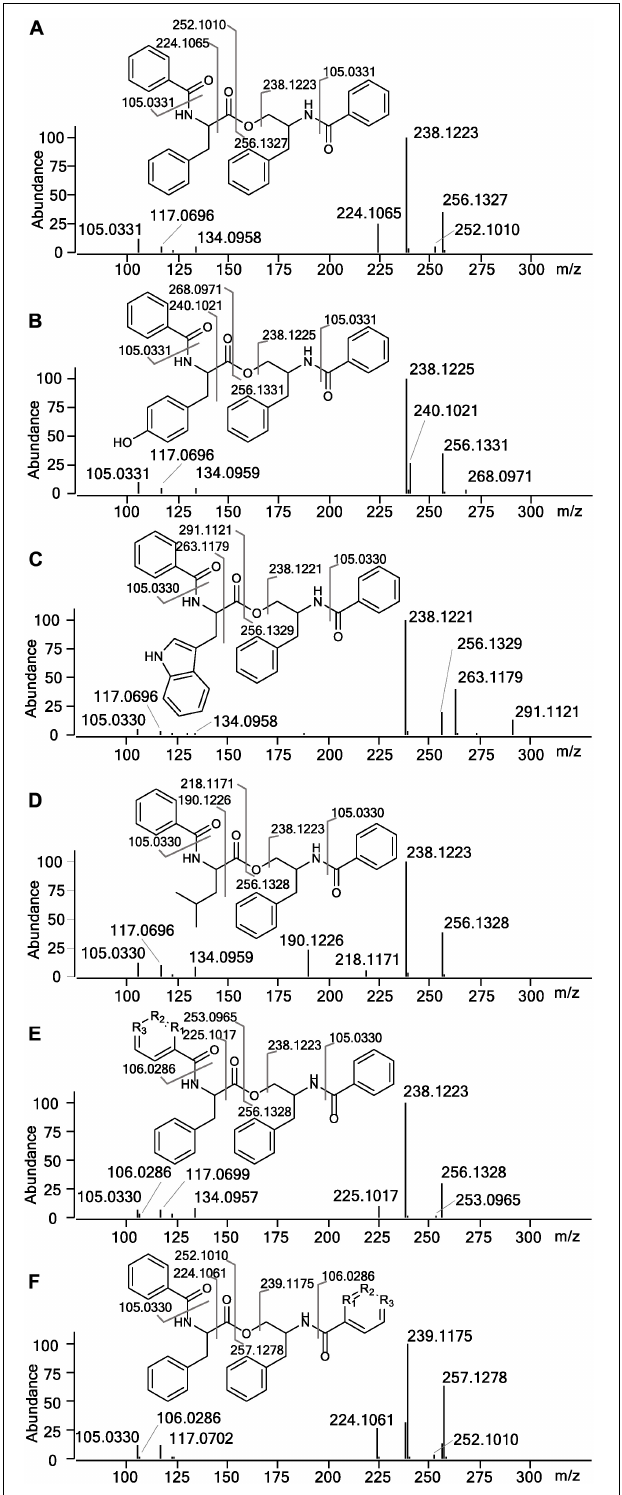
FIGURE 4 | MS/MS spectra and assignment of asperphenamate analogs. (A) Asperphenamate m/z 507.2231, (B) tyrosine analog m/z 523.2227, (C) tryptophan analog m/z 546.2387, (D) leucine analog m/z 473.2435, and (E,F) pyridinecarboxilic acid analogs, where R 1 , R 2 , or R 3 =